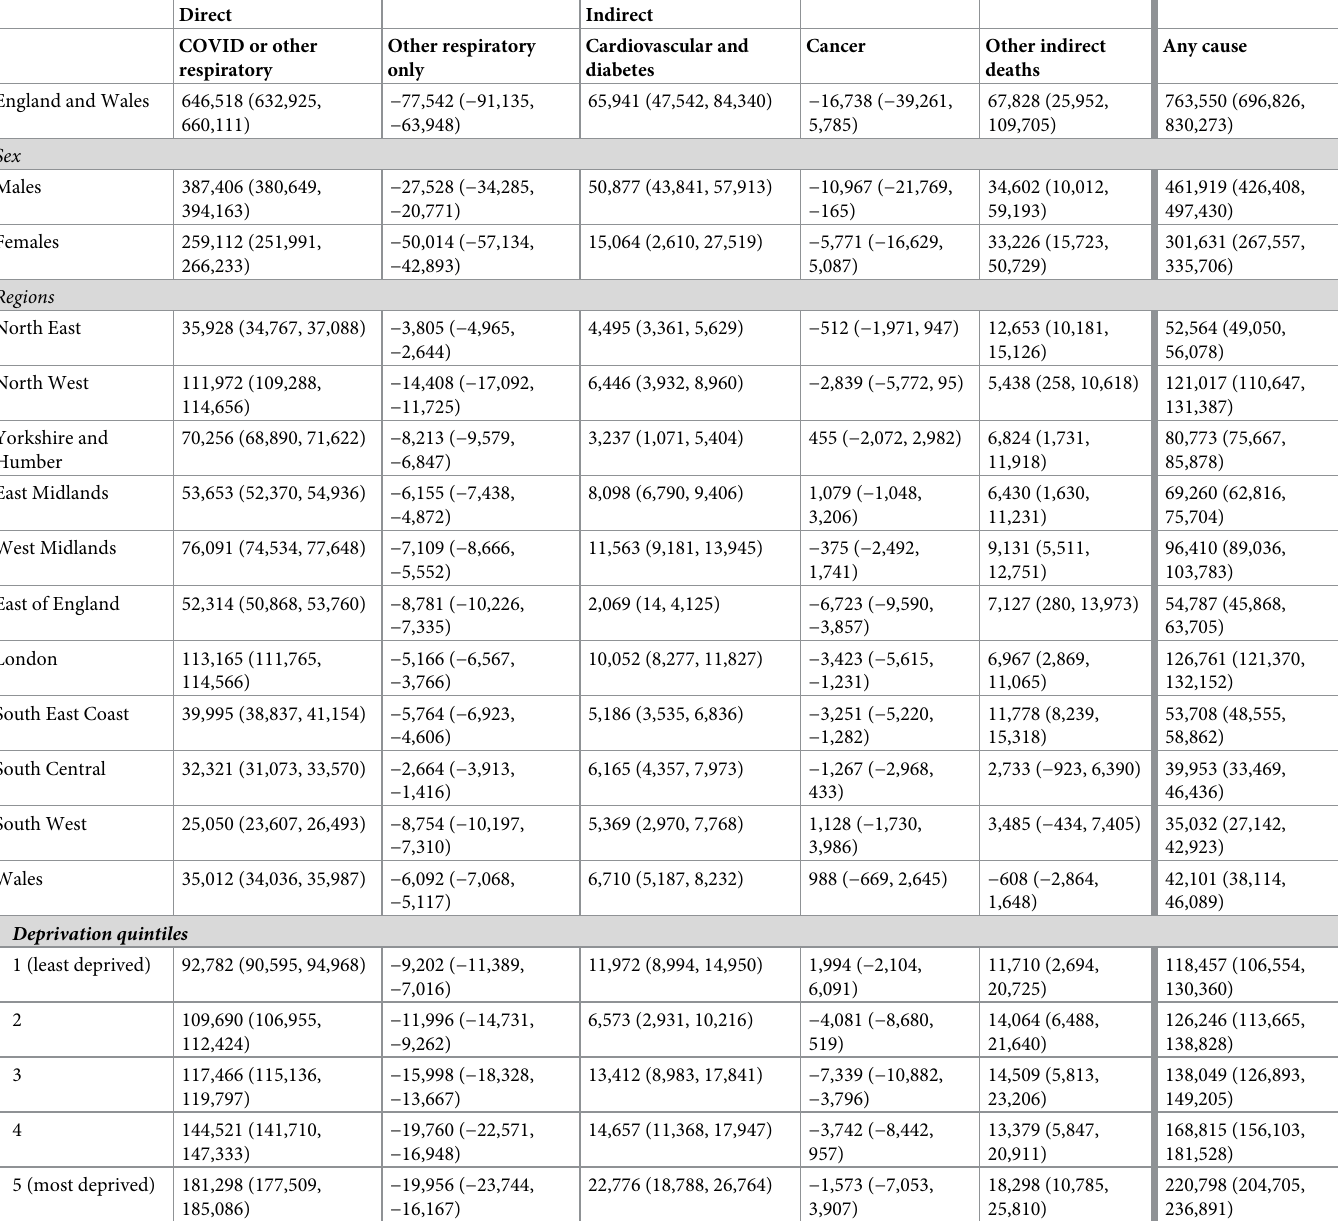
Table 1. Estimated excess YLL (95% confidence intervals), of direct, indirect, and total excess deaths, weeks 11 to 52, 7 March 2020 to 25 December